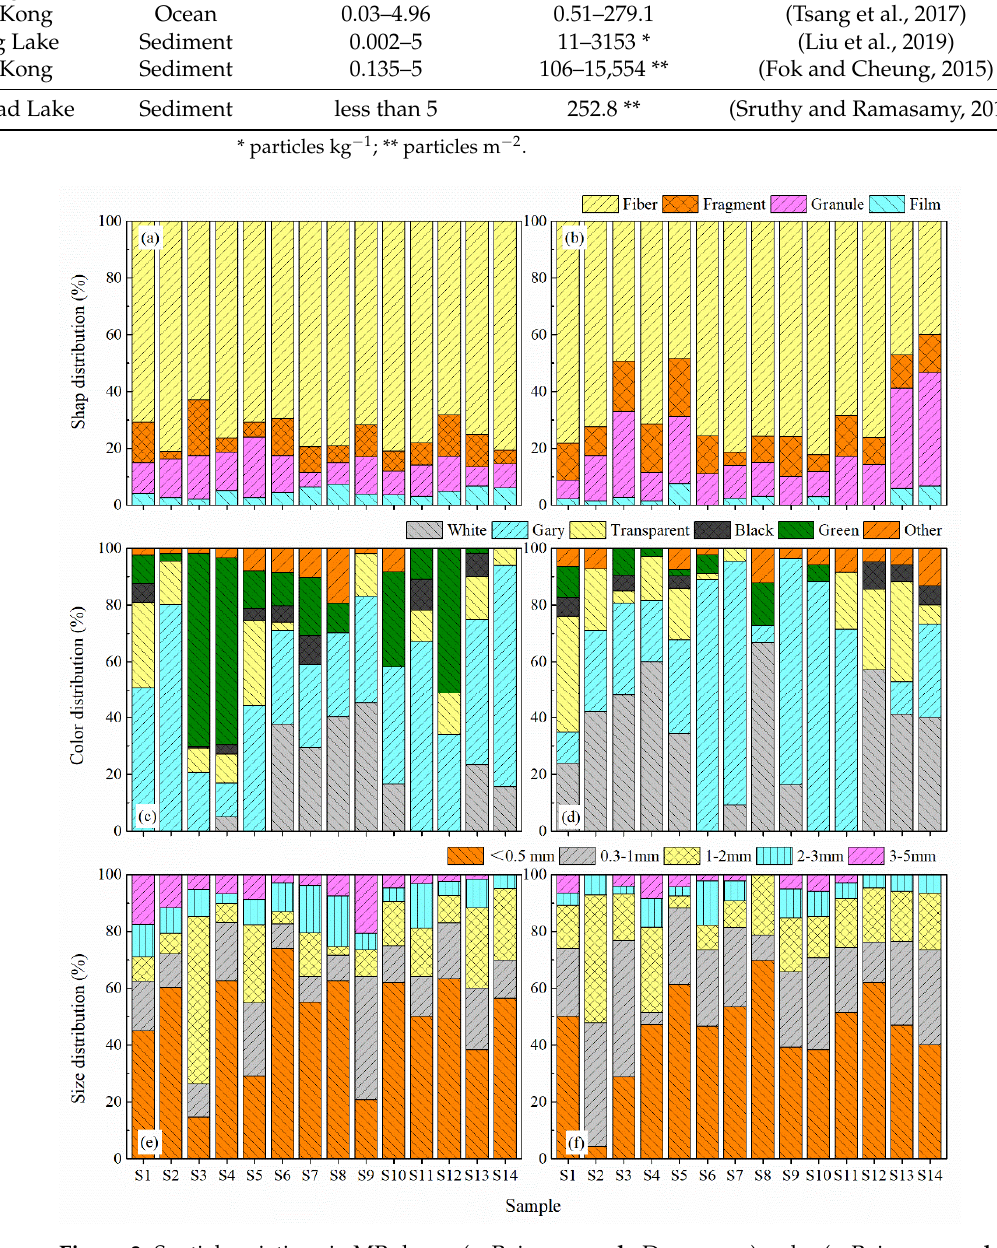
Figure 3. Spatial variations in MP shape: ( a –Rain season, b –Dry season), color ( c –Rain season, d –Dry season) and size ( e – Rain season, f –Dry season). The color of the MP particles can indicate the material and source of the MP particles to some extent. Therefore, MP particles in the coastal waters of this area were classified into five different colors, including white, gray, transparent, black, and green; their tem- poral and spatial distribution is shown in Figure 3c,d. In the rainy season, gray and green MPs accounted for the largest proportion of the total; the average values at each site reached 43.7% and 21.5%, respectively. In the dry season, gray and white MPs were dom- inant, accounting for 42.4% and 31.4%, respectively. The occurrence of different colors of MPs detected in this sampling survey may be due to the fact that the Pearl River, which is located adjacent to the study area, is the second largest water system in China. The socio-economic development in the area is also high. Thus, a wide range of plastic waste types may be weathered and broken during transportation along the Pearl River by sur- face runoff before ultimately entering the sea. The size of MP particles can determine whether they are easily ingested by biota and enter the food chain. Therefore, the analysis of the size of MPs helps to assess the biological risk of MP pollution [37]. In this study, MPs were classified into five size classes: <0.5 mm;